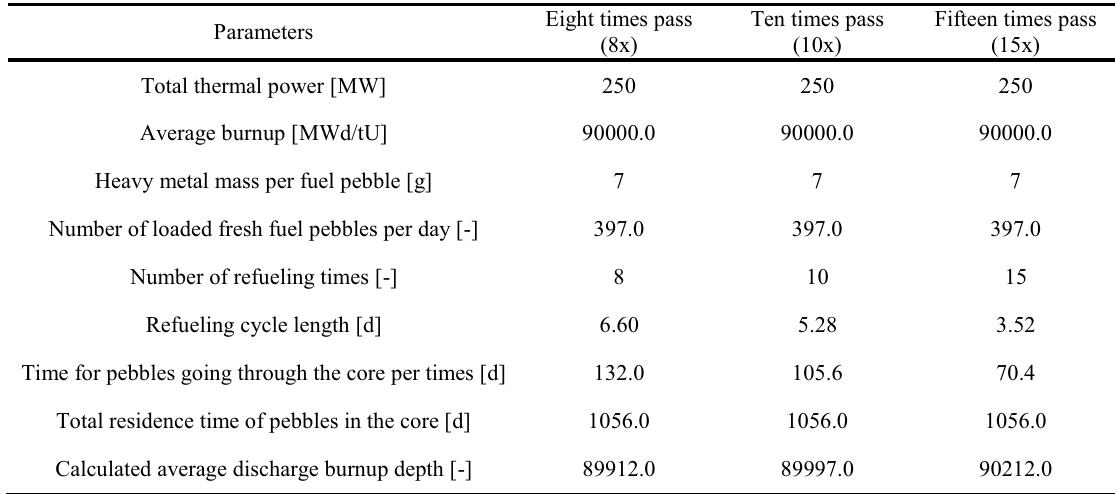
Table I. Main Equilibrium Core Parameters in 8x, 10x and